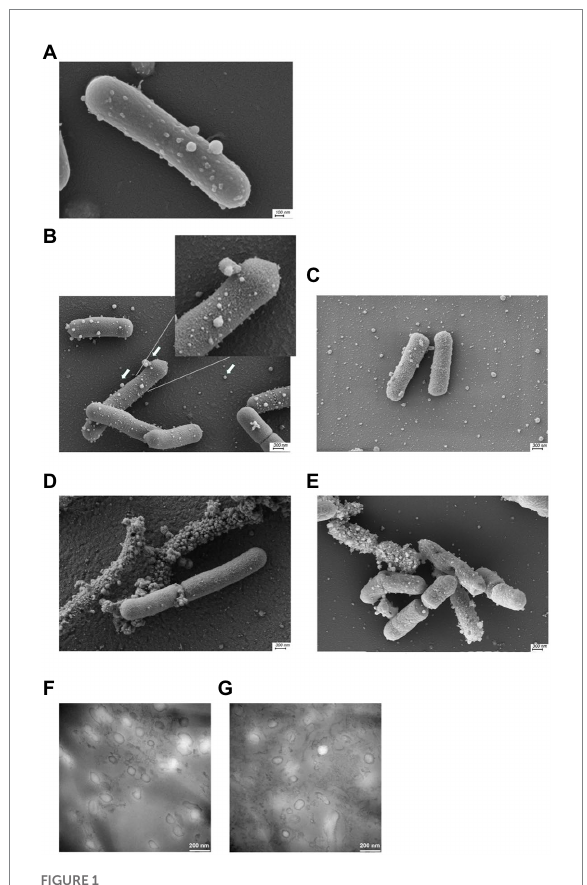
FIGURE 1 Scanning electron microscopy images of L. reuteri cultivated under different conditions. L. reuteri DSM 17938 cultivated in MRS for 24 h with extracellular membrane vesicles of varying sizes budding of the bacterial surface (A) . L. reuteri DSM 17938 after 24 h with (D) /without O 2 stress condition (B) and 48 h (E) of cultivation; BG-R46 after 24 h cultivation (C) . A representative example of three independent experiments is shown. Magnification 40k. Arrows indicate MV budding from the cell surface and released MV. Transmission electron microscopy negative staining analysis of L. reuteri DSM 17938 extracellular membrane vesicles isolated after 24 h (F) and 48 h (G) of